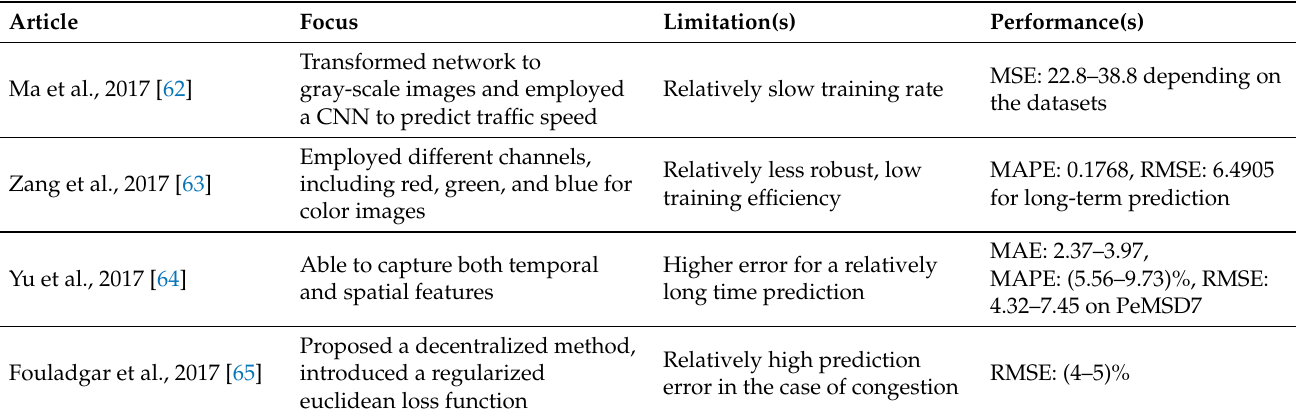
Table 8. Summary of the works found using